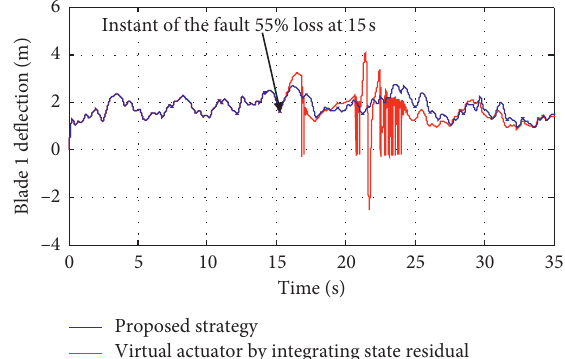
Figure 21: The comparison of the faulty blade 1 deflection between the proposed FTC and the residual integration